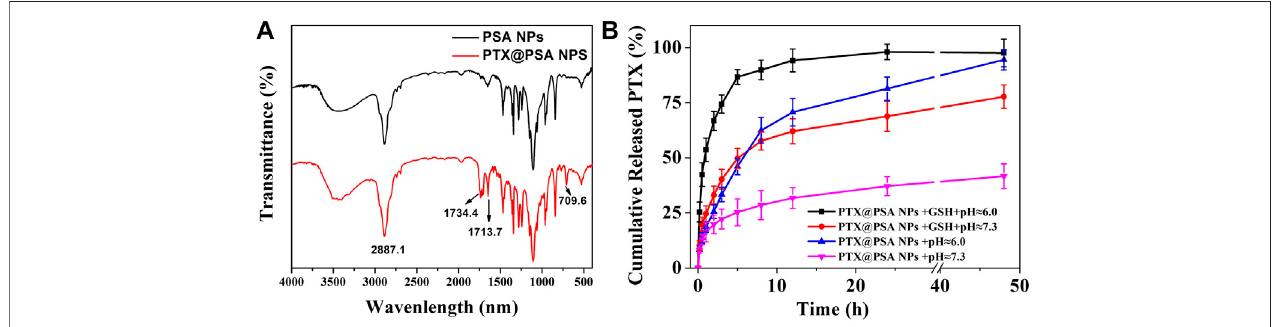
FIGURE 4 | (A) FT-IR spectra of the nano-carriers (PSA NPs) and PTX encapsulation nano-medicine (PTX@PSA NPs). (B) In vitro release of CO from PTX@PSA NPs under stimulation without GSH and acid (PTX@PSA NPs + pH ≈ 7.3), acid (PTX@PSA NPs + pH ≈ 6.0), GSH (PTX@PSA NPs + GSH + pH ≈ 7.3), GSH and acid (PTX@PSA NPs + GSH + pH ≈ 6.0).